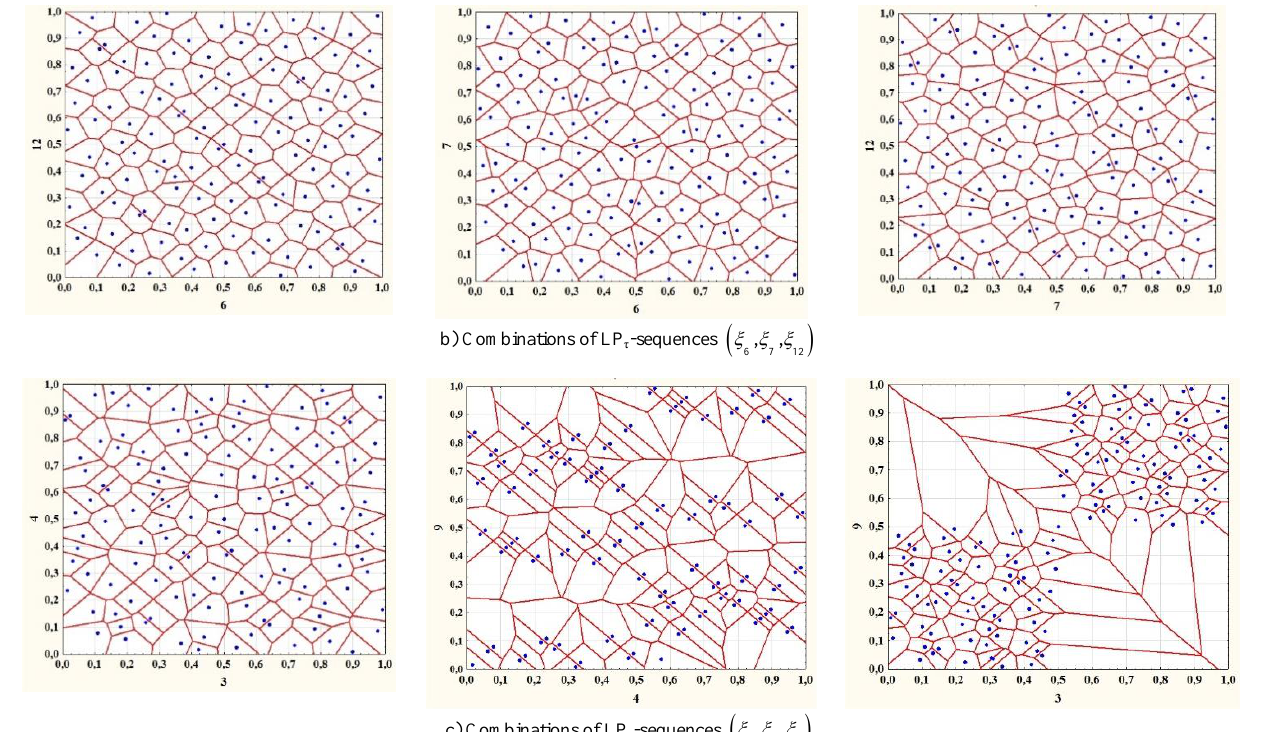
Fig. 3. Voronoi diagrams for projections of three-dimensional